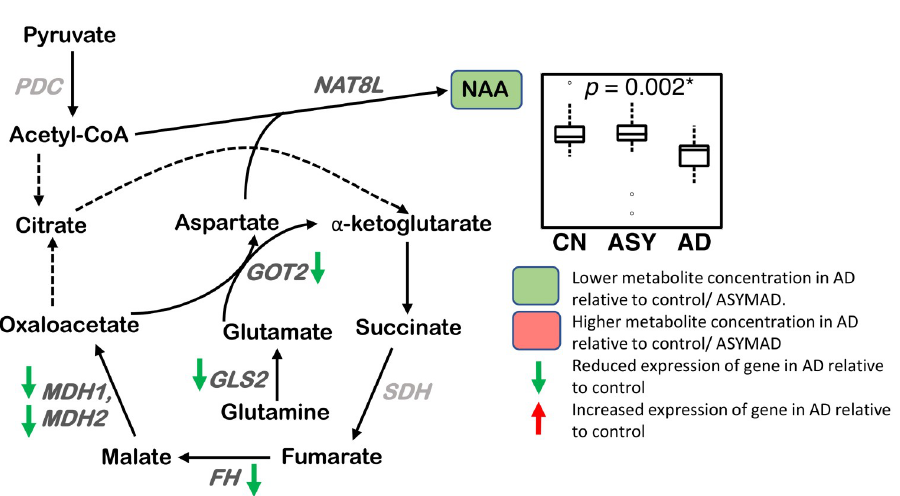
Fig 8. Glutamate-aspartate metabolism. A lower concentration of NAA is observed in AD in the ITG. The genes FH, MDH1, MDH2, GLS2, and GOT2 have reduced expression in the hippocampus/ERC in AD compared to CN. Sample size: AD = 17, ASY = 13, CN = 13; p -values indicate significance after FDR correction for multiple comparisons. Genes in light gray indicate expression data were not available. An asterisk ( � ) indicates metabolite was also significant after Bonferroni correction. Genes in light gray indicate expression data were not available. AD, Alzheimer disease; ASY, asymptomatic AD; CN, Control; CoA, coenzyme A; ERC, entorhinal cortex; FDR, false discovery rate; FH, fumarase; GLS2, glutaminase 2; GOT2, aspartate aminotransferase; ITG, inferior temporal gyrus; MDH1, malate dehydrogenase 1; MDH2, malate dehydrogenase 2; NAA, N-acetyl aspartate; NAT8L, N-acetyltransferase 8 like; PDH, pyruvate dehydrogenase complex; SDH, succinate dehydrogenase.